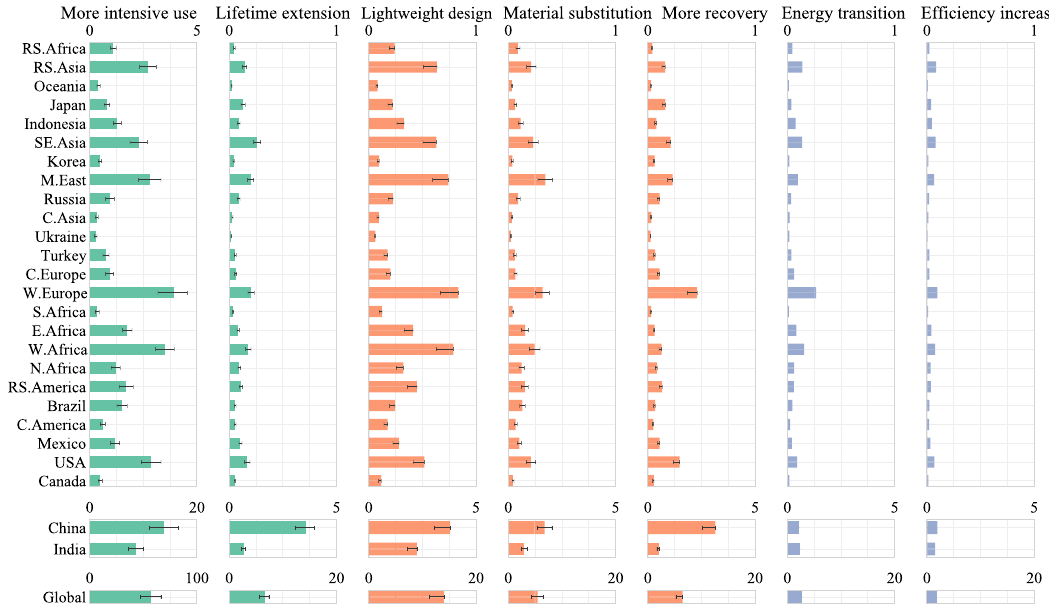
Fig. 2 Greenhouse gas (GHG) emission mitigation potential during 2020 – 2060 by different material ef fi ciency strategies. The three colors left to right represent the three layers in the modeling framework: building demand, material demand, and material supply (see Supplementary Fig. 1). These three approaches correspond approximately to the general “ avoid – shift – improve ” emission mitigation framework 43 . The whiskers represent the sensitivity intervals of GHG in the High Ef fi ciency (HE) scenario (given by 20 percentage point variations for each strategy; see the Supplementary Information for further details). Note that the scales for Global, the China region, and India differ from other regions, and the scale for ‘ more intensive use ’ differs from other